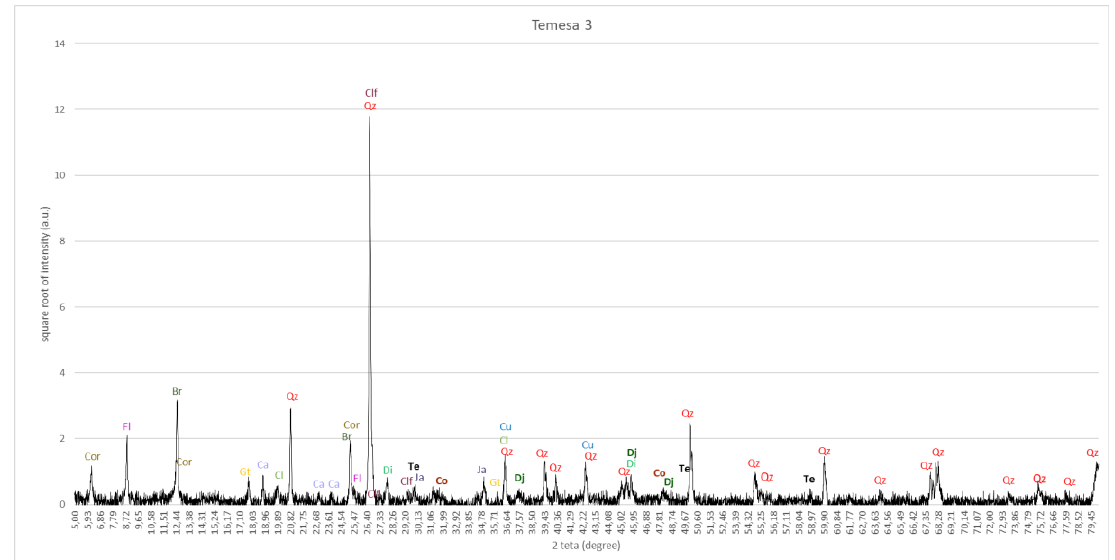
Figure 9. Temesa 3: XRD pattern. Abbreviations: Cor — corrensite, Fl — phlogopite, Gt — goethite,